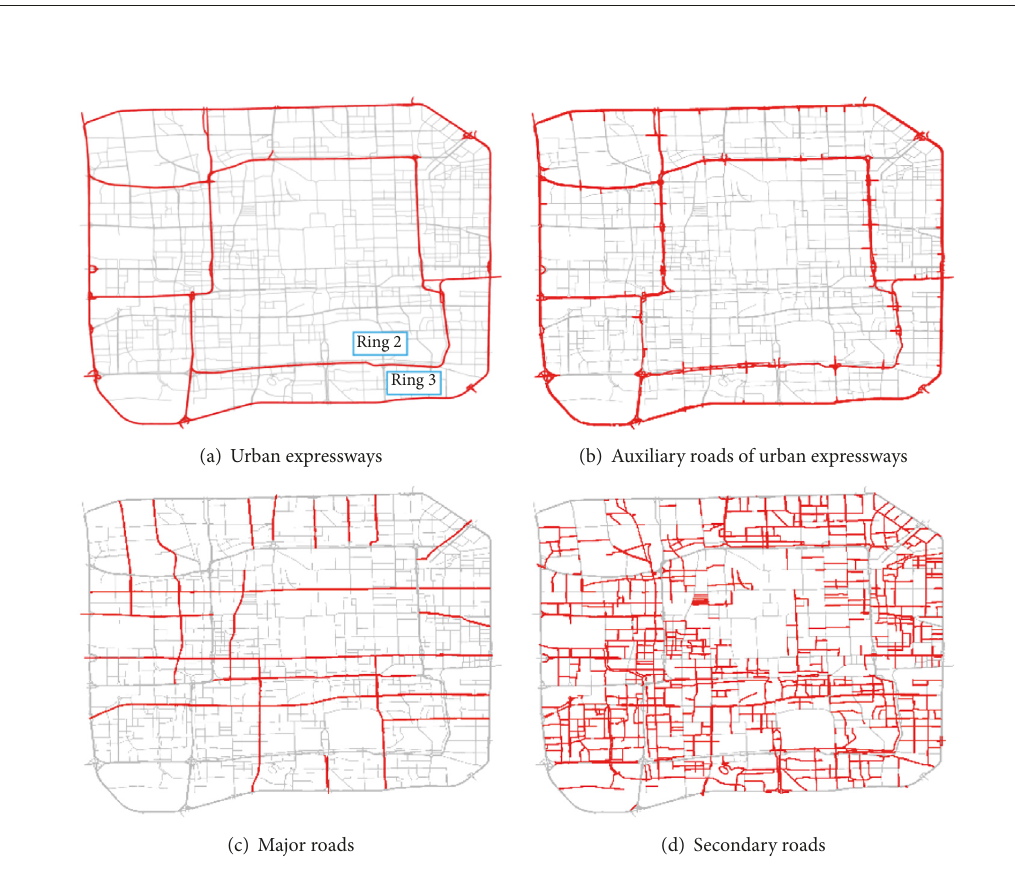
Figure 1: Spatial distribution of different types of